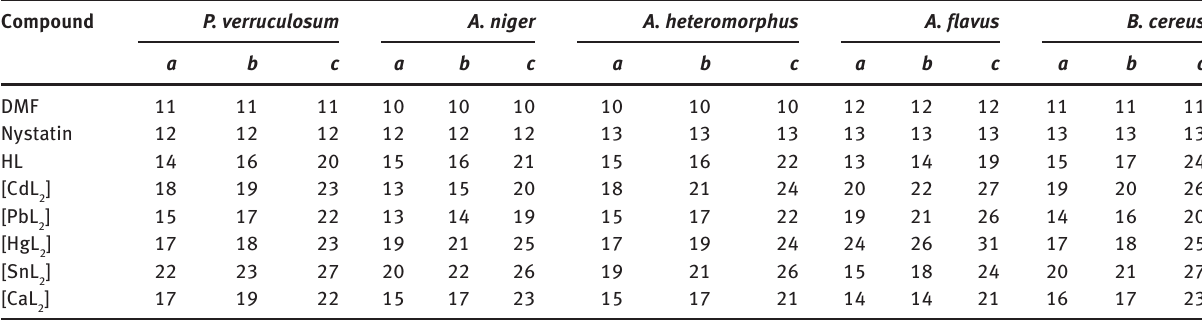
Table 4 Antimicrobial activity (diameter inhibition zone in millimeters) of curcumin (HL) and its metal complexes.